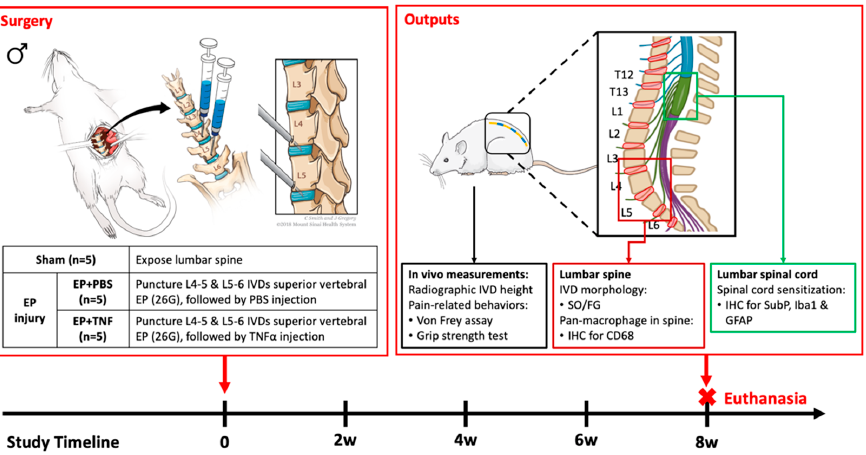
Figure 1. Schematic image of EP injury with anterior approach surgery. Surgical methods and study design [19] with sham ( n = 5); EP + PBS ( n = 5) and EP + TNF ( n = 5), output measurements and timeline.